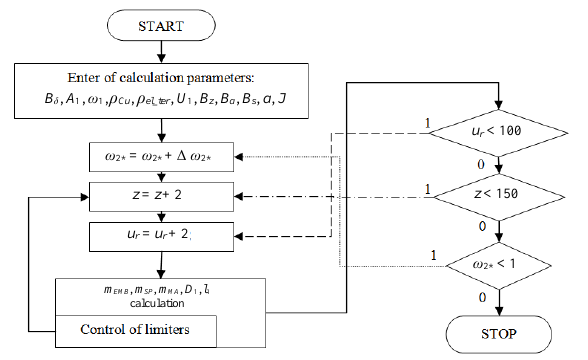
Fig. 2. Calculation program logical scheme.